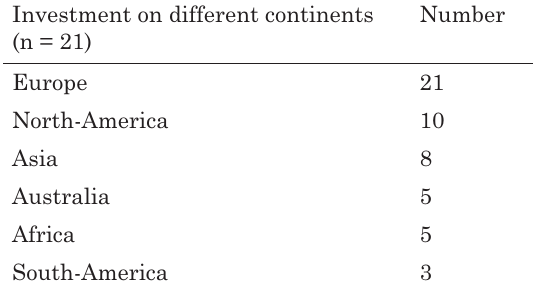
Table 5. Respondents property investments